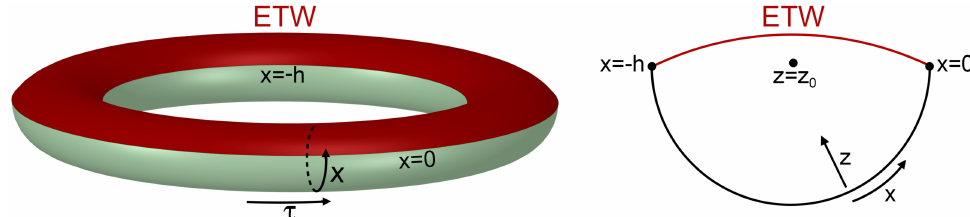
Figure 7 . Left: bulk dual of the finite cylinder in the thermal AdS 3 phase. The contractible x circle, with circumference 2 h , is cut off at x = − h, 0 at the boundary. A single connected ETW brane emerges from the asymptotic boundary at { z = 0 , x = − h } , extends into the bulk until the turning point at z = z , and reaches the asymptotic boundary again at { z = 0 , x = 0 } . In the max positive tension brane case depicted here, the spacetime is enlarged with respect to the tensionless case, and more than half of the torus is retained in our geometry. The bulk domain is given by √ 2 h/π ]; x ∈ [ − h, h ] } \ { τ ∈ [ − π, π ]; z ∈ [0 , z ]; x ∈ [ x + ( z ) , x − ( z )] } , where { τ ∈ [ − π, π ]; z ∈ [0 , 2 max th th we are subtracting from the full torus the portion excised by the ETW brane. Right: fixed τ slice of the thermal AdS geometry cut off by a (positive tension) connected ETW brane anchored at the 3 boundary at antipodal points of the contractible